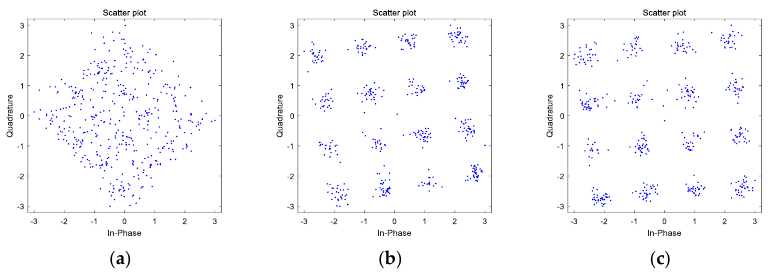
Figure 11. The constellations of the 16QAM signals in the polluted regions: ( a ) distorted weak 16QAM; ( b ) weak 16QAM after mitigation without delay; and ( c ) weak 16QAM after mitigation at the best delay.